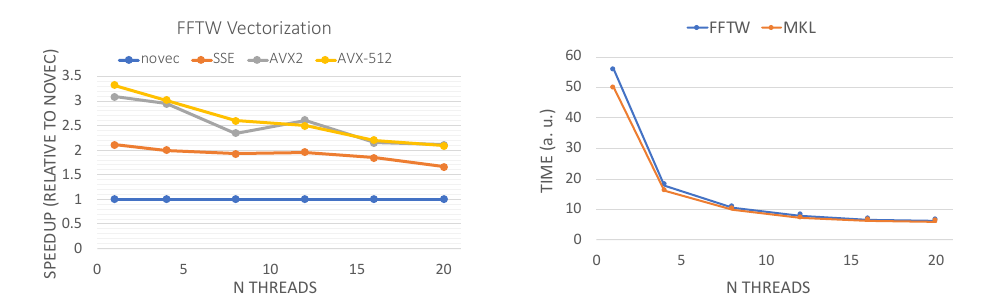
Figure 4. Left: speedup of FFTW compiled with di ff erent vector instruction sets relative to compilation without vector instructions (labeled "novec"), as a function of the number of threads. Right: execution time using MKL and FFTW libraries as a function of the number of